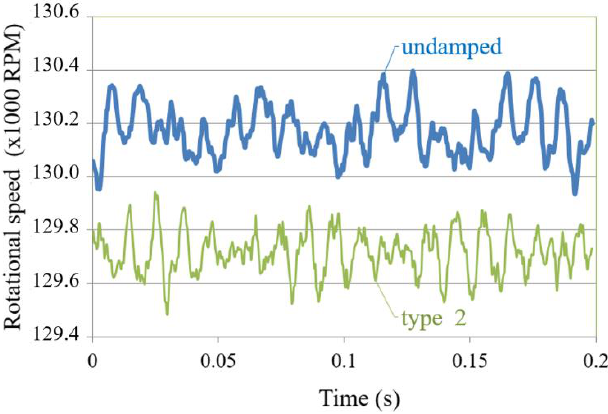
Figure 8. Rotational speed changes of roller bearings at resonance peak. Table 3. Summary of results.